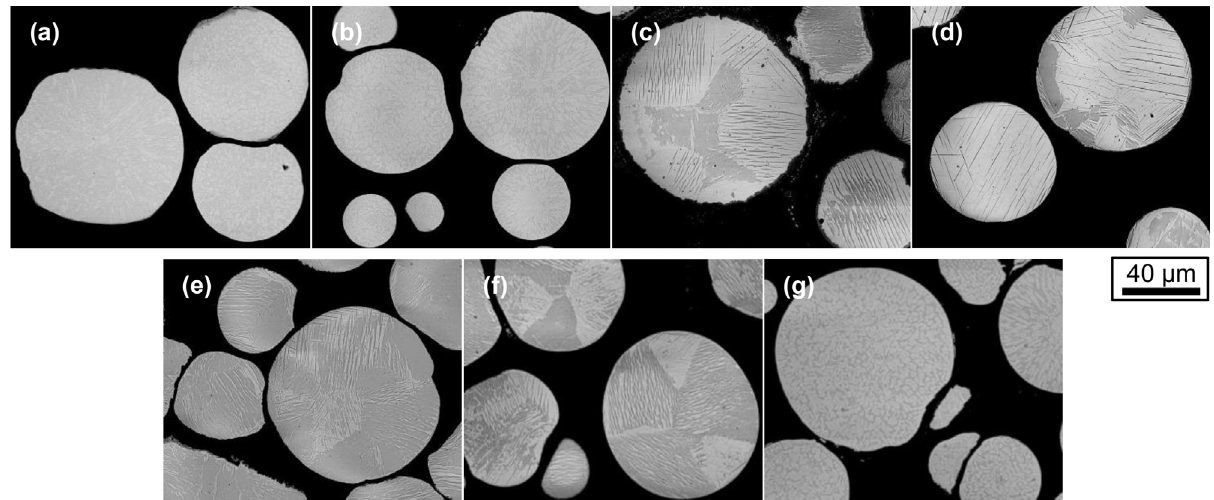
Fig. 3. U(Mo) particles microstructure, observed by SEM (BSE mode) in (a) EMP-711, (b) EMP-717, (c) EMP-803, (d) EMP-819, (e) EMP-828, (f) SF-202, (g) SF-402 plates.